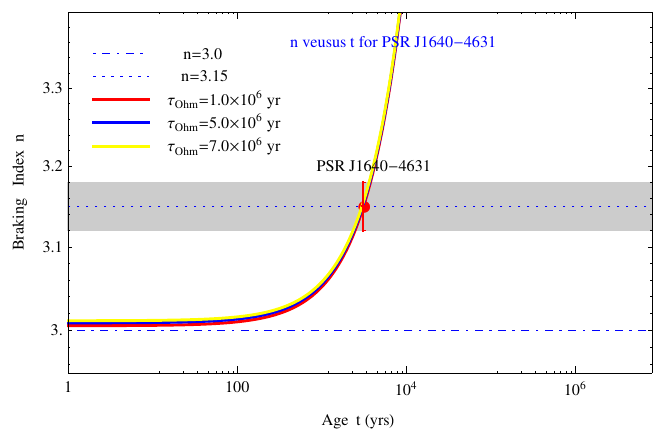
Figure 4. Braking index as a function of t for PSR J1640-4631. Here, the measured value of n is shown with the red